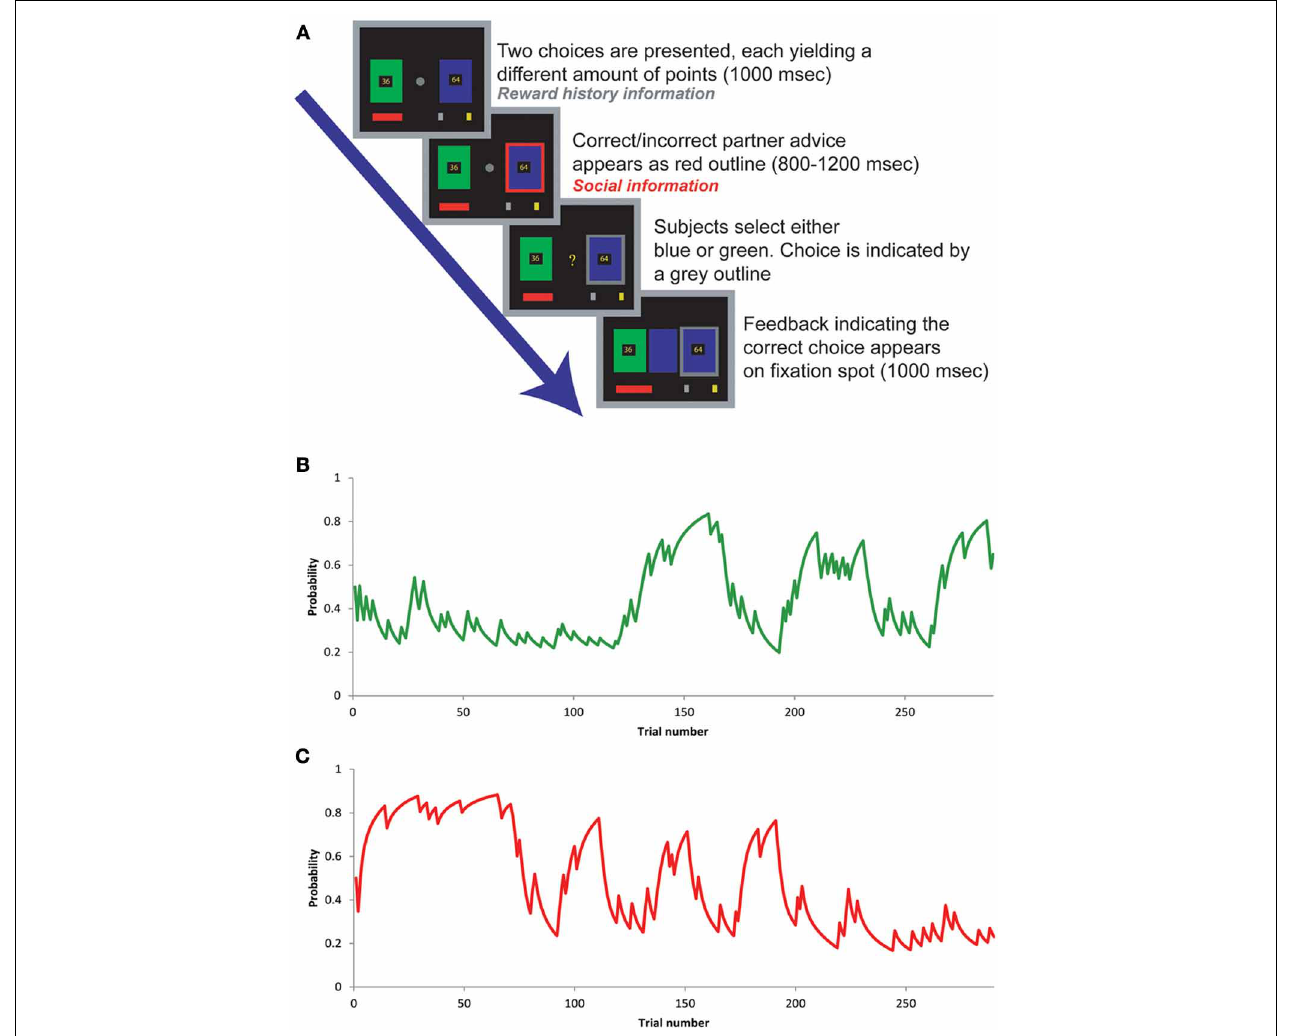
FIGURE 1 | (A) Sequence of events and their timings during the experiment. (B) Probability of reward from choosing green card through the experiment. The line shows the probability estimated by the Bayesian reinforcement learning model. (C) The figure shows the